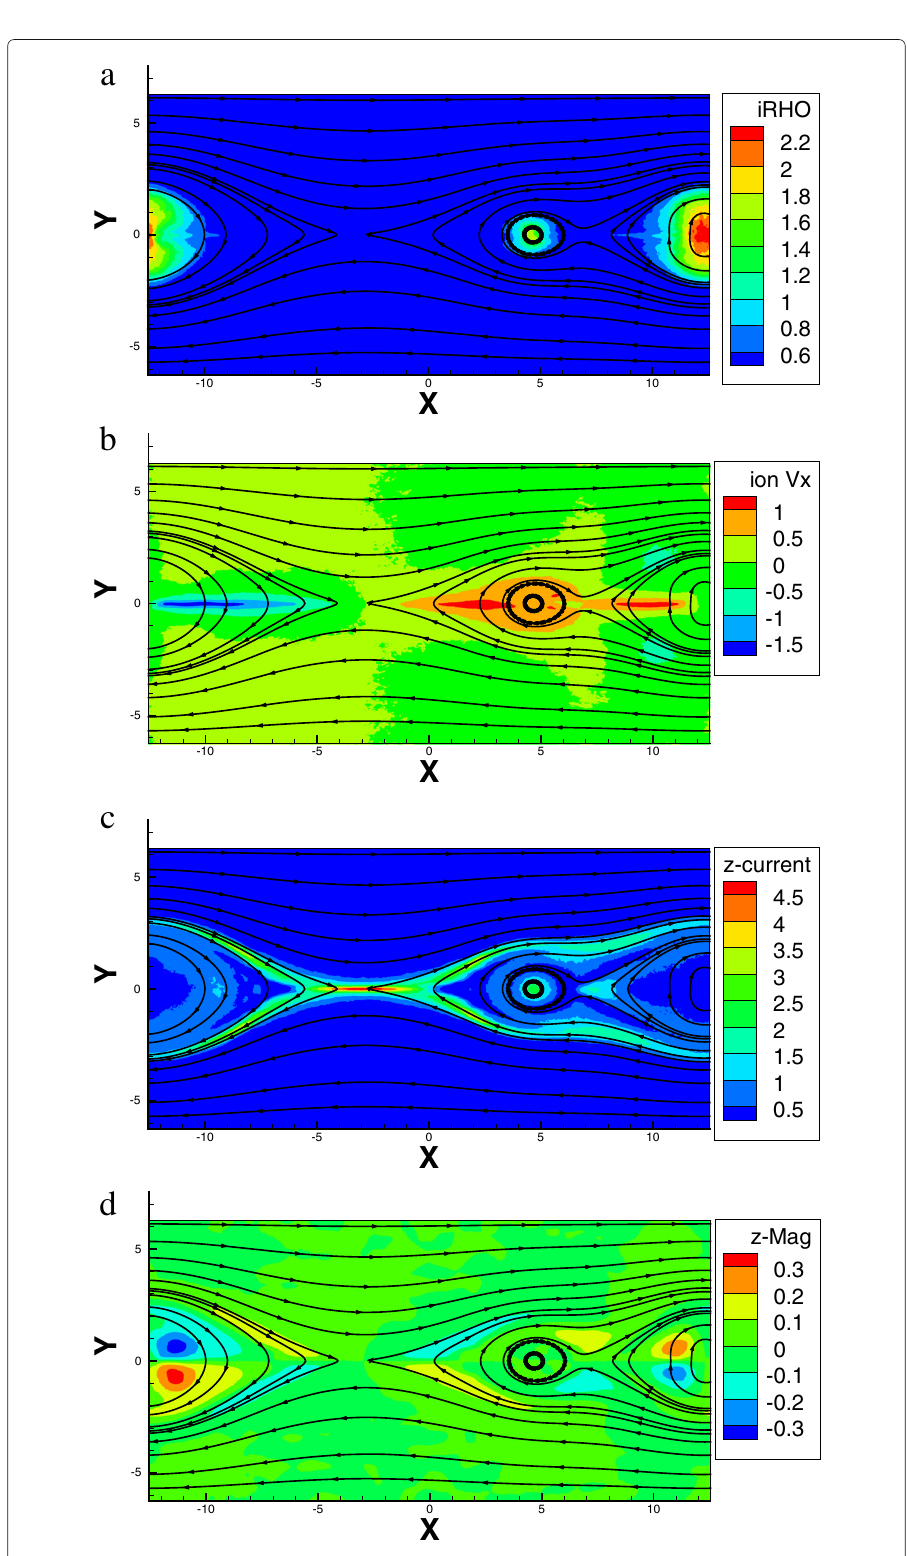
Fig. 18 The UGKWP results of magnetic reconnection with Kn=10 3 at pi